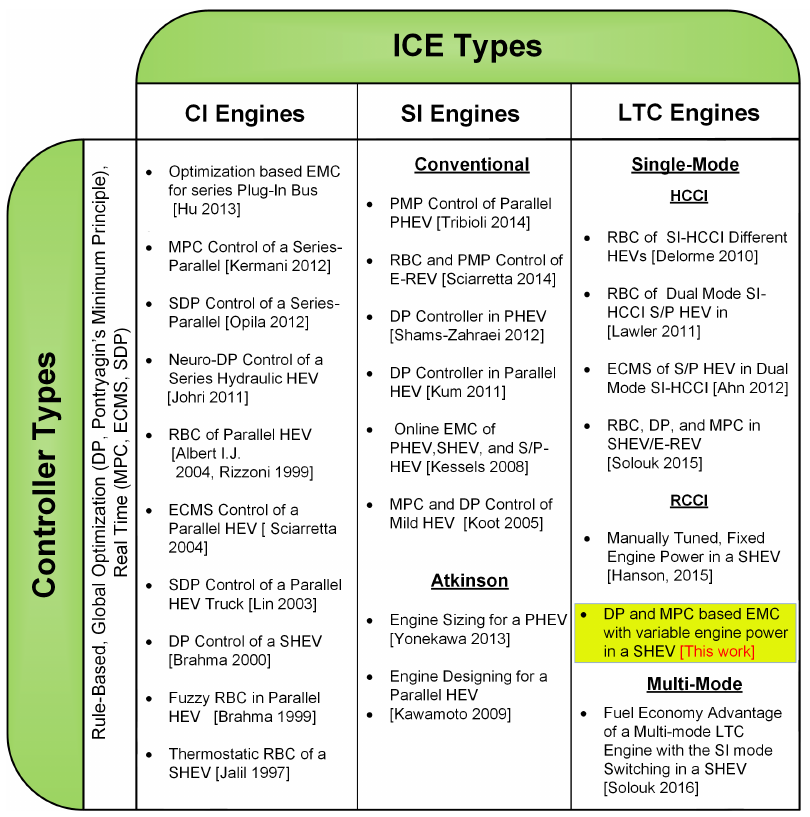
Figure 1. Prior studies categorized based on different types of internal combustion engines (ICEs) and energy management control (EMCs) incorporated in hybrid electric vehicle